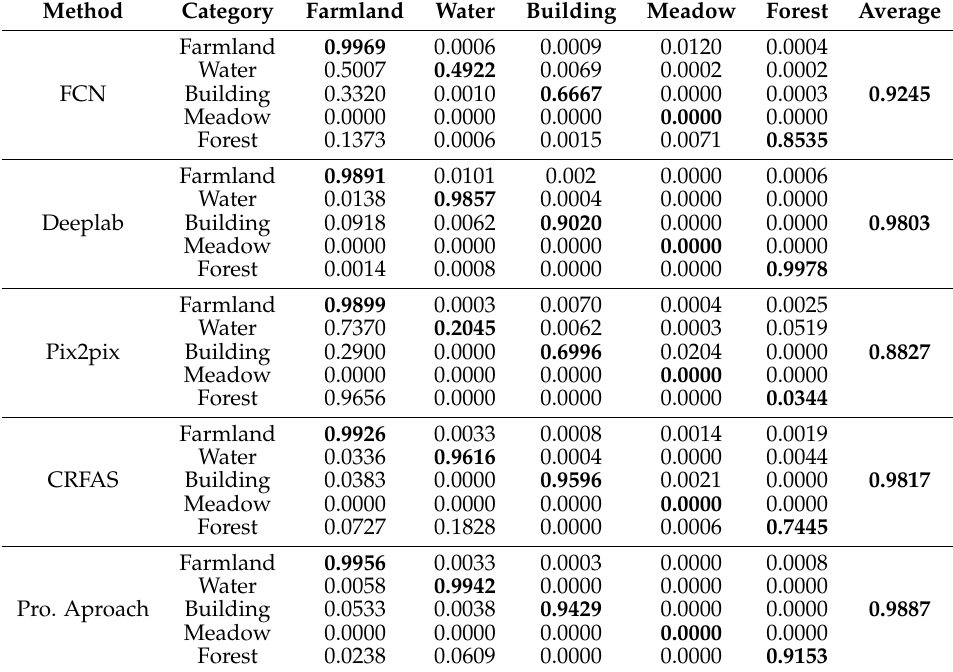
Table 3. Confusion matrix for